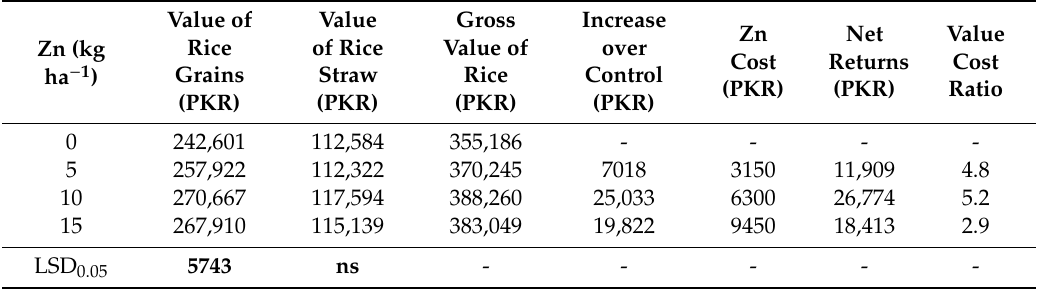
Table 4. Impact of zinc levels on the economic analysis (net returns and value cost ratio) of rice crop under rice–wheat cropping system.